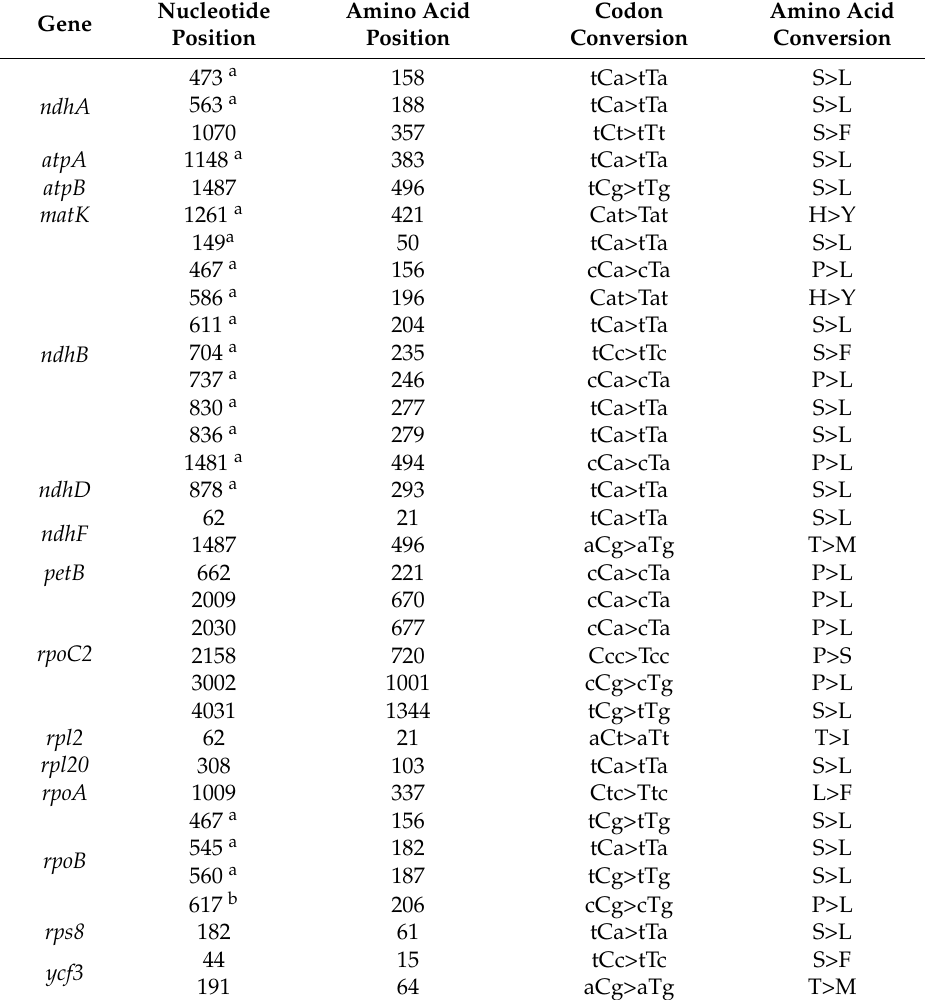
Capitals in column Codon Conversion indicate target nucleotides. a Editing sites with experimental verification. b Unedited by experimental